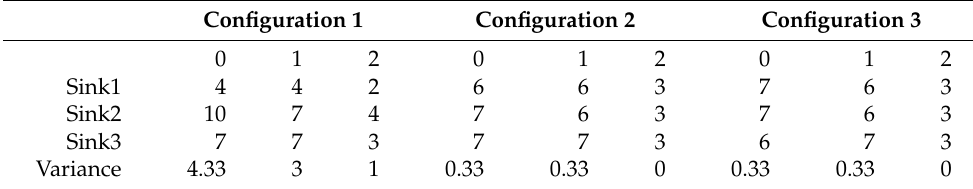
Table 5. Node migration: Node